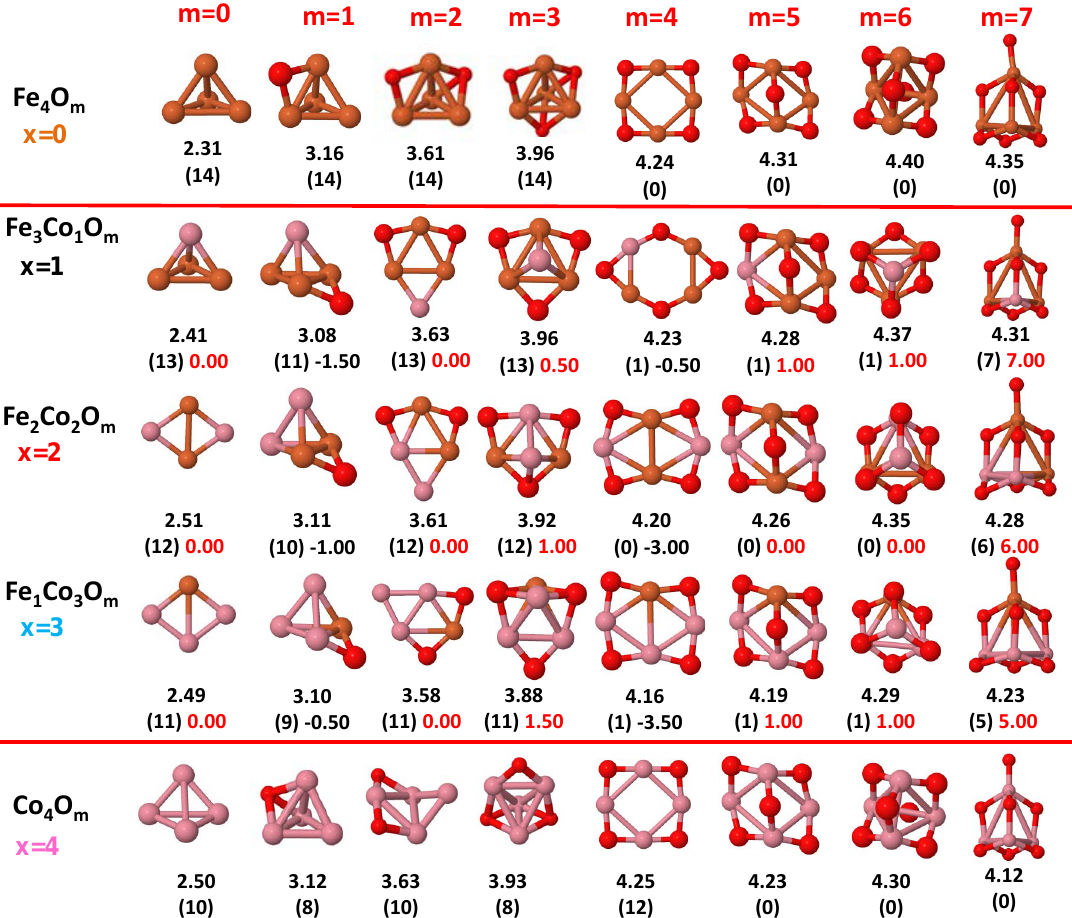
Figure 7. Putative global minimum structures of Fe 4 − x Co x O m , x = 0–2, m = 1–6. Numbers below structures are the binding energy per atom (in eV), numbers in parentheses are the magnetic moment (in µ B ) and the third number (when present) is the excess magnetic moment (in µ B ) defined in Equation (2). Fe atoms in brown color, Co atoms in pink and oxygen atoms in